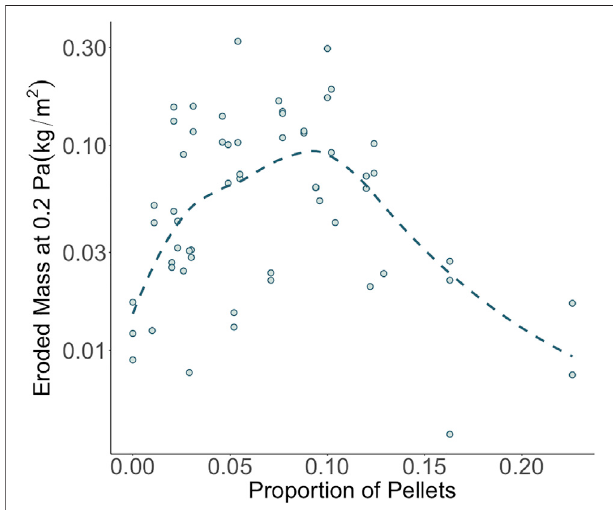
FIGURE 10 | Eroded mass at 0.2 Pa versus the proportion of total sedimentmasscomposed ofresilient pelletsfor thetopcentimeterofall cores sampled for pellets. A superimposed smoother highlights the possibility of a non-linear relationship between eroded mass and pellet proportion.